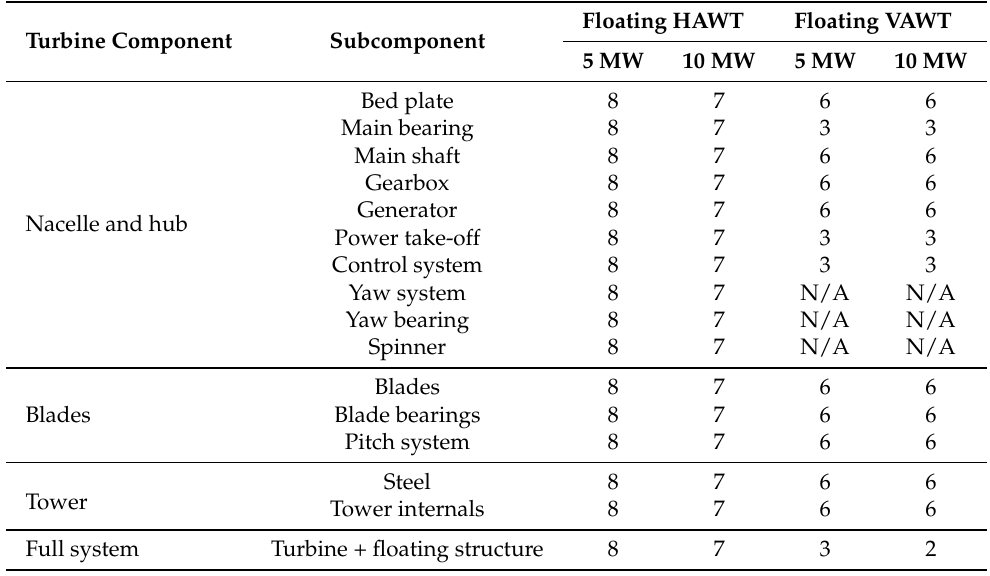
Table 4. TRL assessment of 5 MW and 10 MW floating offshore HAWT and VAWT at subcomponent and at full integral level. The TRL level is ranked between 1 to 9, and N/A is used when the subcategory does not apply to the type of